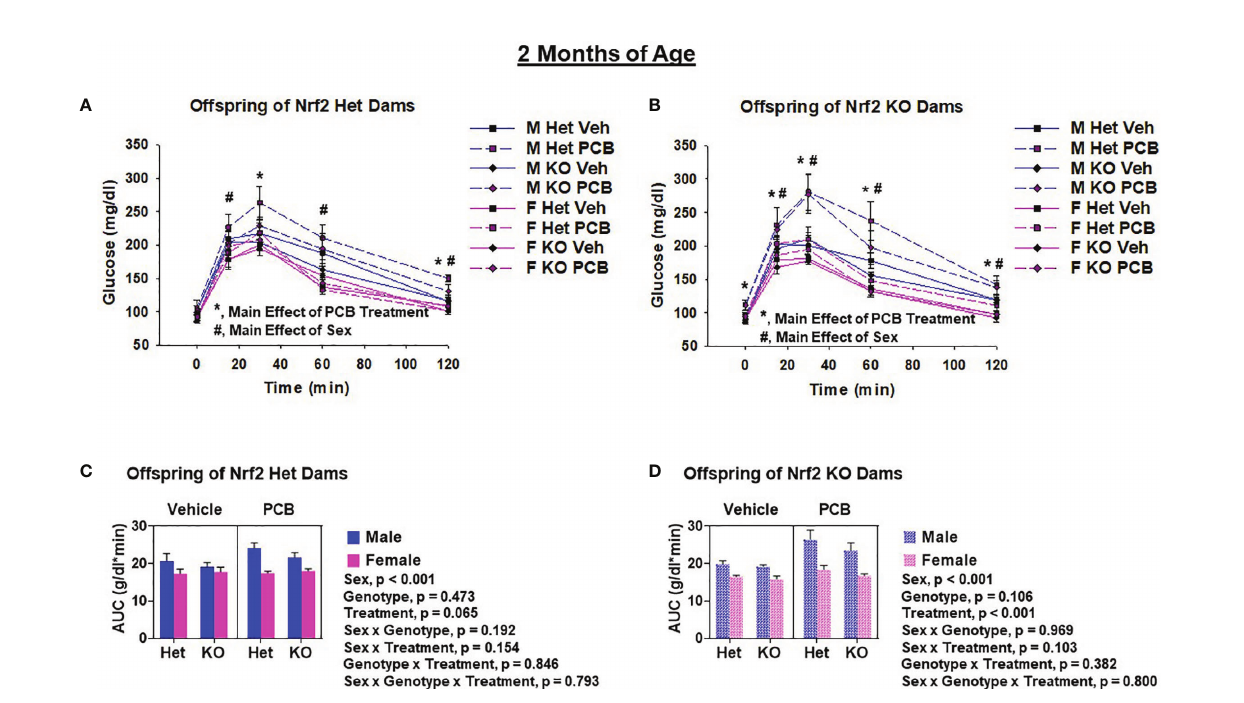
FIGURE 5 | Two-month-old offspring exposed to PCB126 during gestation exhibit impairments in glucose tolerance. At two months of age, glucose was measured in Nrf2 heterozygous and knockout offspring exposed to PCB126 or vehicle during gestation in response to an oral glucose challenge (A, B) . Glucose measurements were then used to determine area under the curve (AUC; C, D ). Offspring glucose and AUC values are representative of the mean of litter means (n = 8 per group) ± SEM. Three-factor ANOVA at each time point was used to detect differences between groups. Signi fi cance was set at a = 0.05. For simplicity, only signi fi cant main effects of PCB treatment (*) and sex (#) are shown at each time